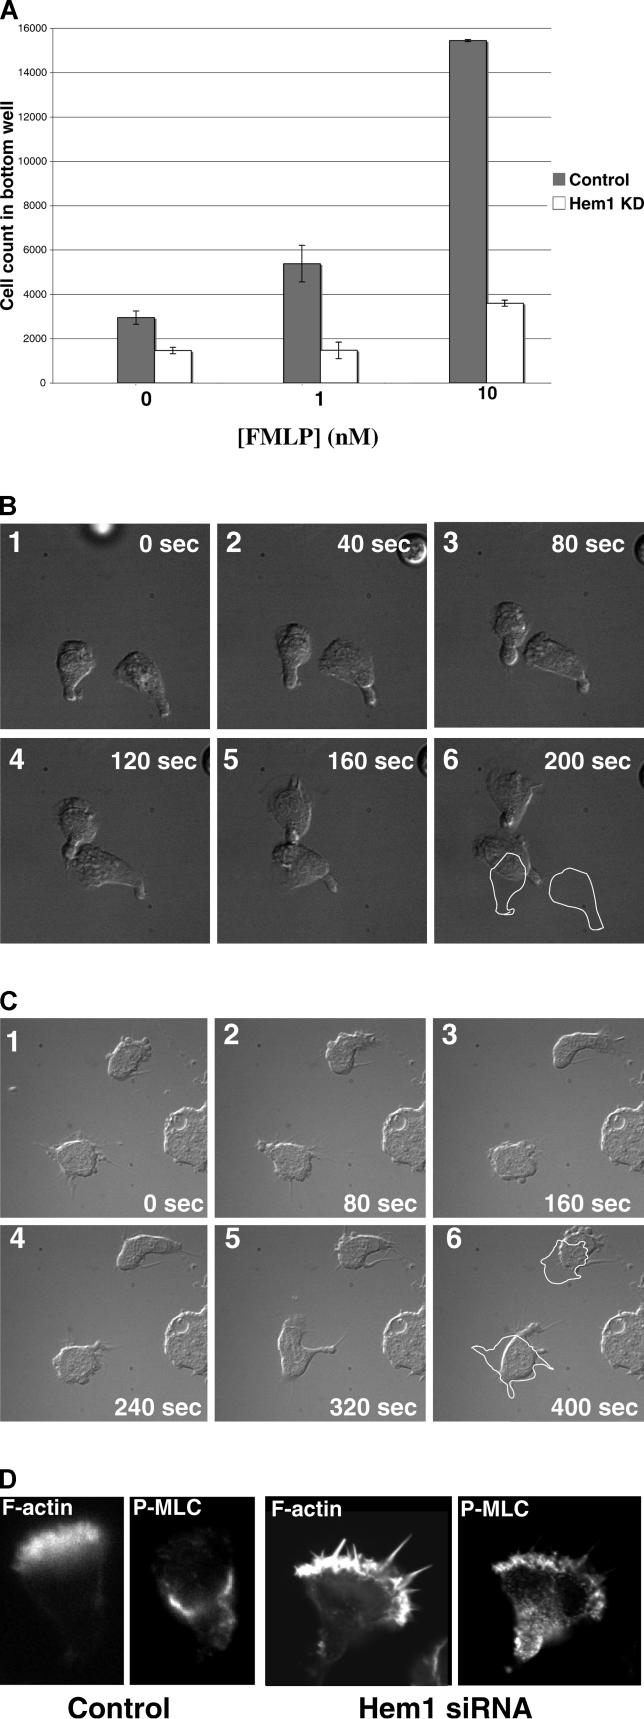
Chemotaxis, Stable Polarity, and the Spatial Regulation of Myosin Phosphorylation Are Dependent on Hem-1(A) Equal numbers of differentiated control or Hem-1 knockdown cells were placed in the top of a Boyden chamber with the indicated concentration of chemoattractant in the bottom chamber. The y-axis indicates count of cells in bottom (chemoattractant) well at 3 h following stimulation. Results are shown with standard error for experiment performed in triplicate.(B,C) Time-lapse Nomarski images of control (B, Video S2) or Hem-1 knockdown (C, Video S3, Video S4) cells sandwiched between two coverslips and exposed to uniform 20 nM fMLP. Last frame shows outline of cells from first frame. Time in seconds from first frame (cells were prestimulated for 3 to 5 min prior to imaging).(D) Hem-1-knockdown cells fail to properly inhibit myosin light chain phosphorylation at the leading edge. Control or Hem-1 knockdown cells were stimulated with 20 nM fMLP for 3 min, fixed, and stained with fluorescent phalloidin to visualize filamentous actin or with antibodies to phosphorylated myosin light chain (phospho-Ser19). Representative staining for polarized cells is shown.